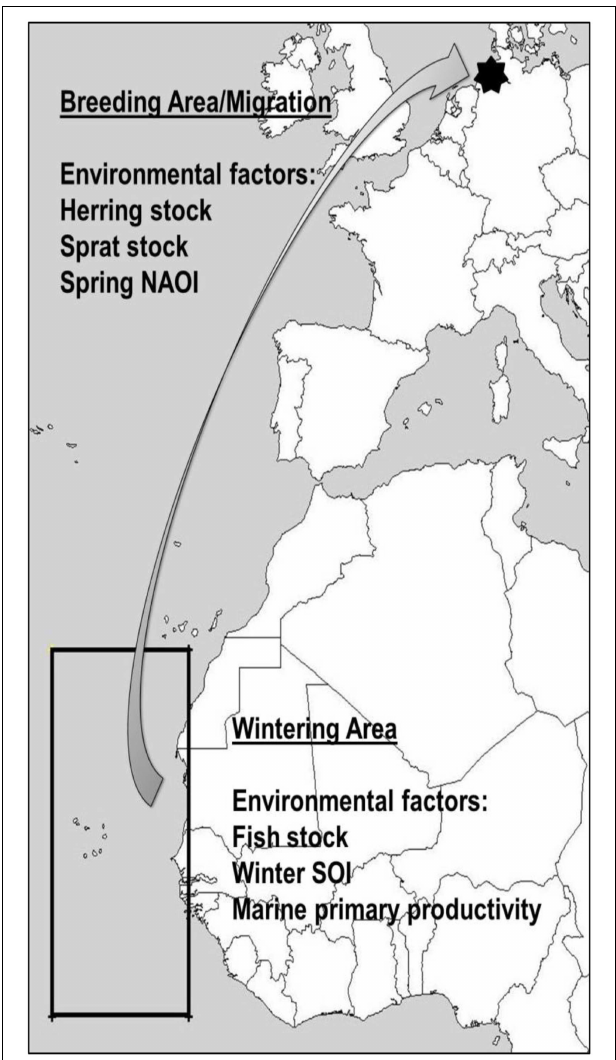
FIGURE 1 | Wintering and breeding area of the Banter See common terns, as well as approximate spring migration route. Environmental covariates are given, along with the geographical locations where they are expected to affect common terns from the study colony.